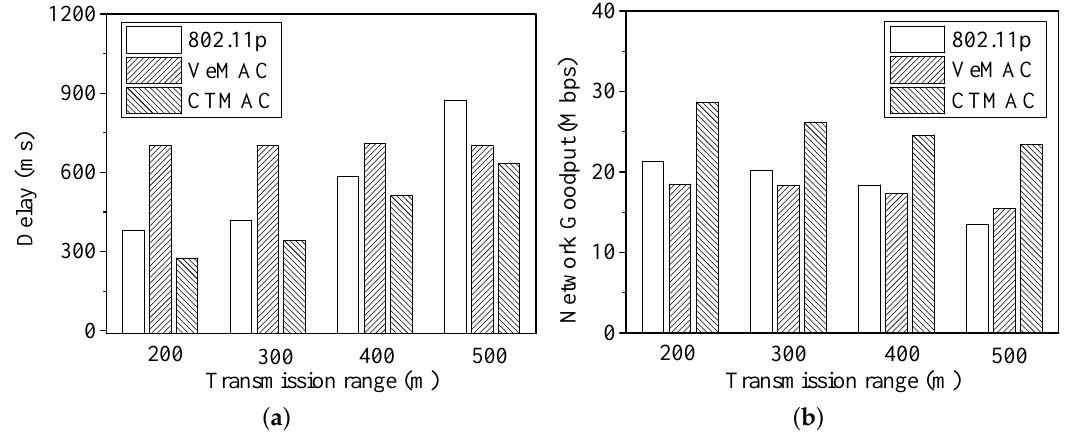
Figure 7. ( a ) Delay; and ( b ) network goodput under different transmission